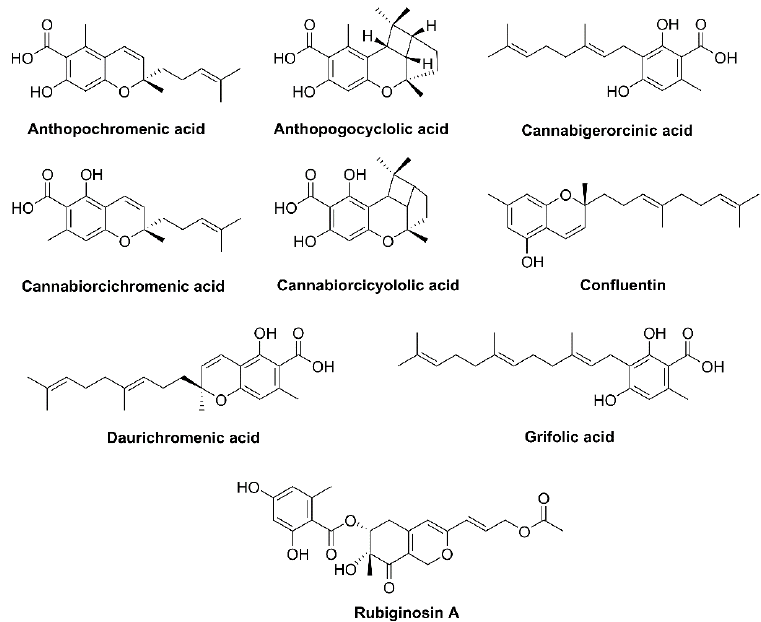
Figure 3. Structure of phytocannabinoids in Rhododendron plants.